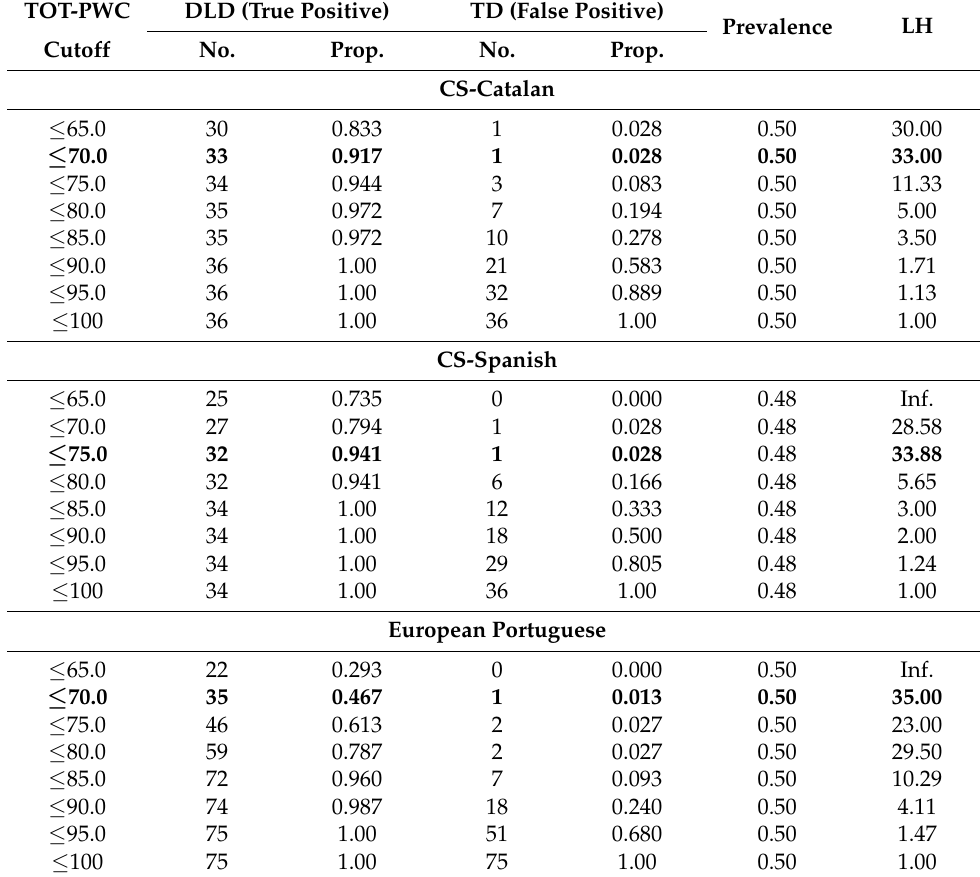
Table 6. The number and proportion of children with a positive test result (ruling in disorder), Prevalence and Likelihood Ratio (LH) for each of the cutoff values based on total word percent correct (TOT-PWC) on the NRT for the Catalan–Spanish (CS) and European Portuguese (EP) children with developmental language disorder (DLD) and typically developing (TD)